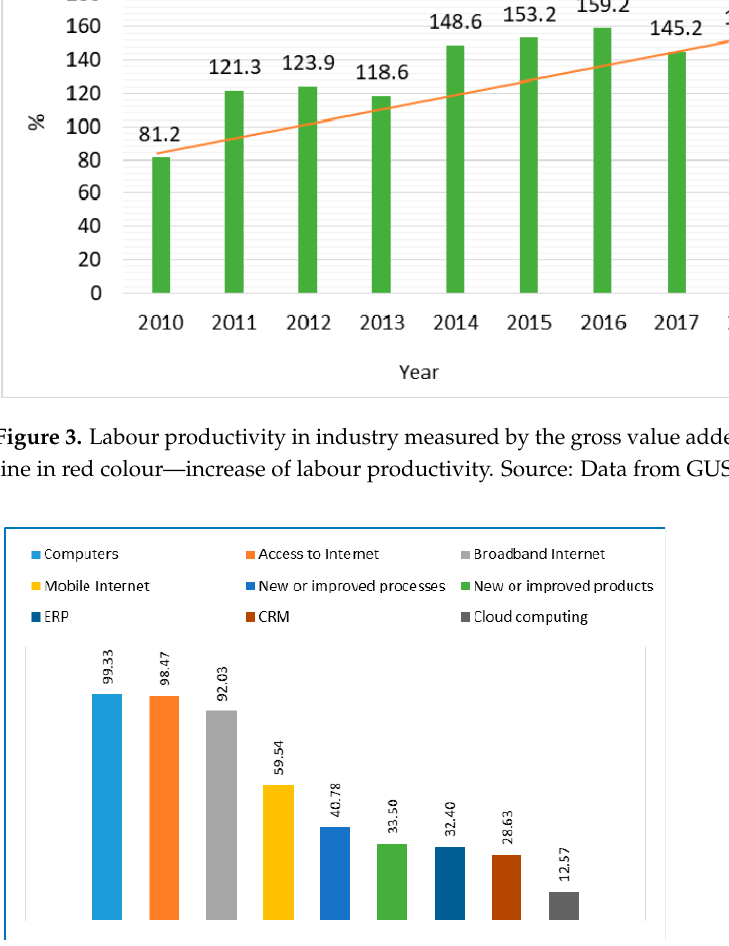
Figure 3. Labour productivity in industry measured by the gross value added in Poland.